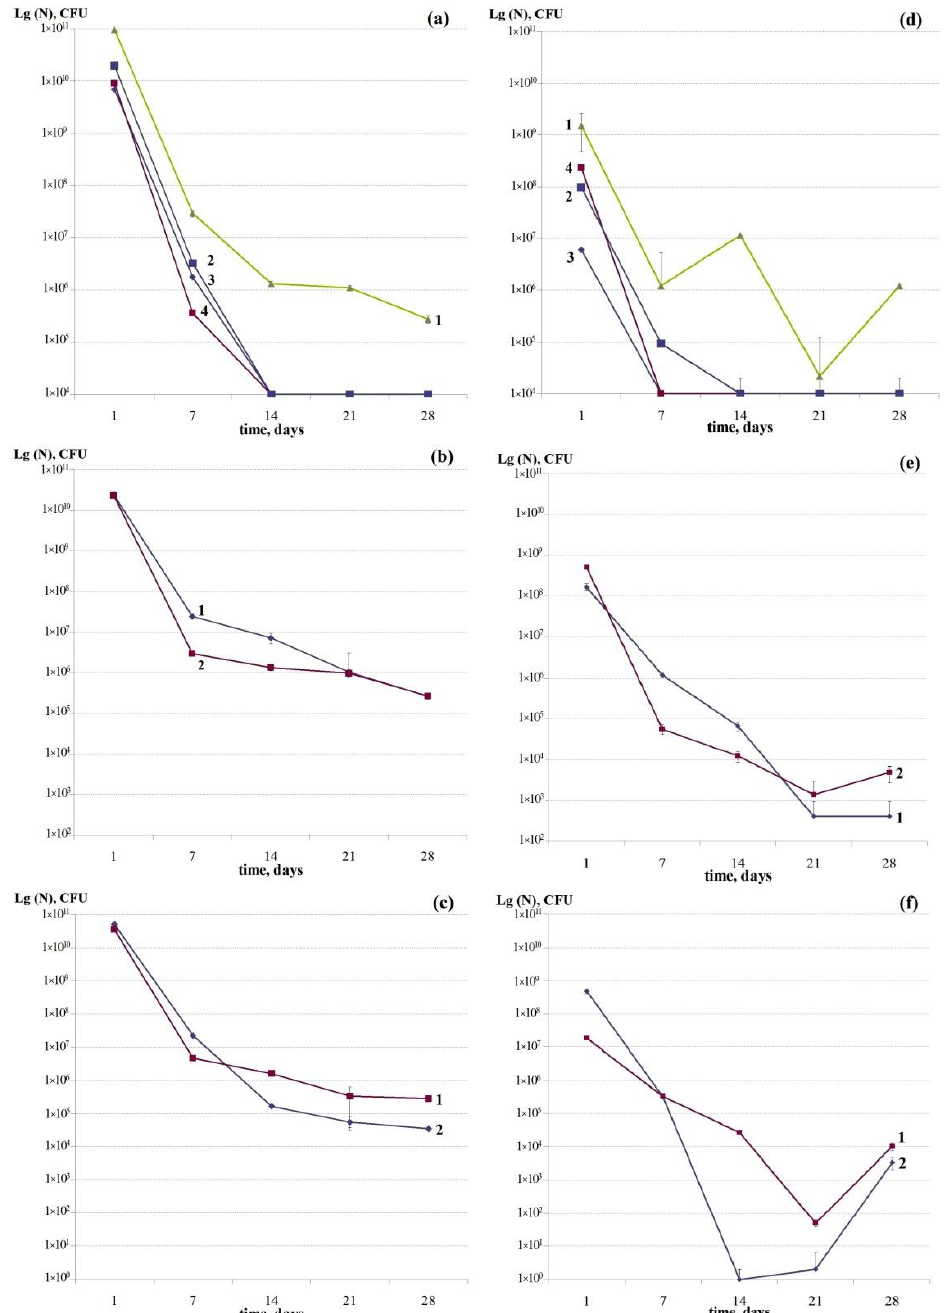
Figure 1. Dynamics of changes in the total number (CFU ml − 1 ) of cells (TNC) ( a – c ) and the number of thermoresistant cells (TRCs) ( d – f ) in the periodic planktonic bacterial cultures: ( a , d )— P. aeruginosa (1), P. extremorientalis (2), P. antarctica (3); P . gessardii (4), ( b , e )— E. coli (1), S. typhimurium (2); ( c , f )— S. aureus (1), K. rhizophila (2).